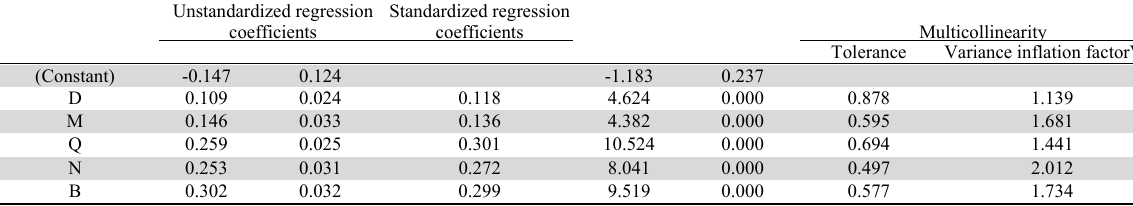
Regression results